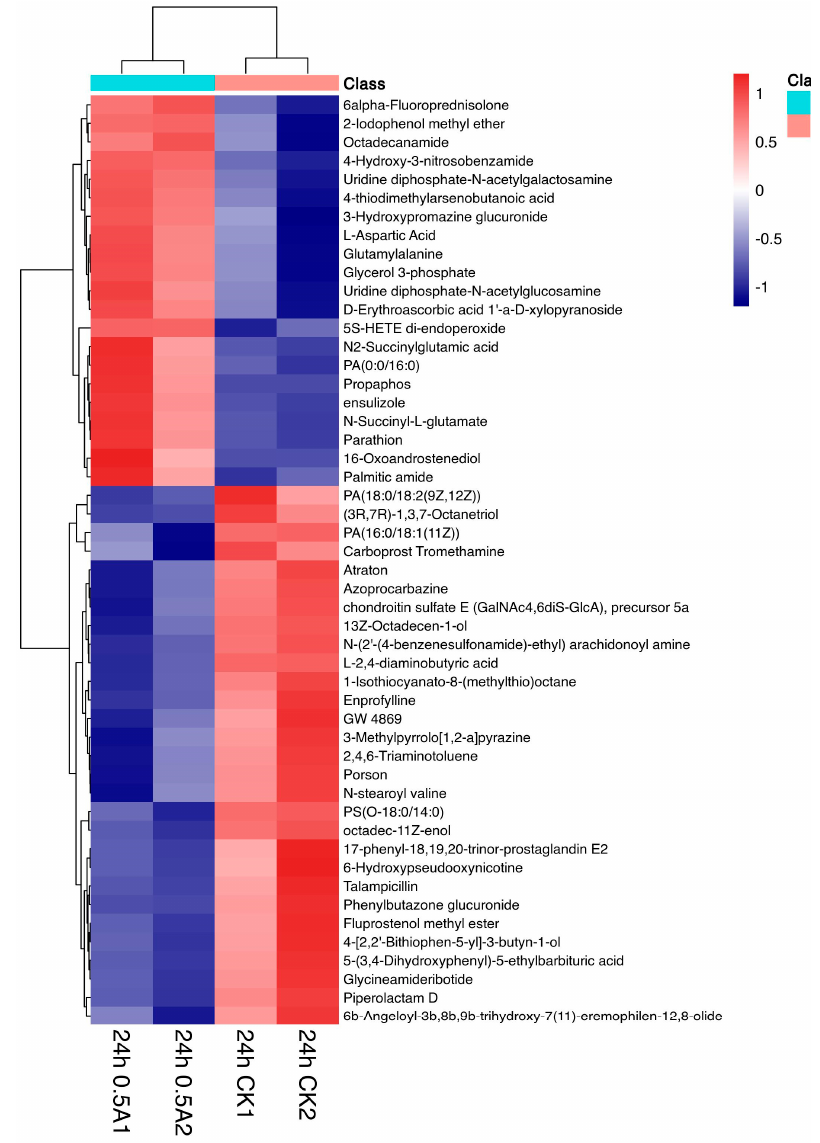
Figure 7. Hierarchical clustering heat map analysis of differential metabolites in the 24-h 0.5 A~24-h CK group (the abscissa indicates the sample name, 24-h CK is the control group, 24-h 0.5 A is the experimental group, and the ordinate indicated differential metabolites). Red and blue represents up-regulation and down-regulation, respectively. The colour from blue to red indicates that the expression abundance of metabolites was from low to high. That is, the deeper the red expression, the higher the abundance of differential metabolites.